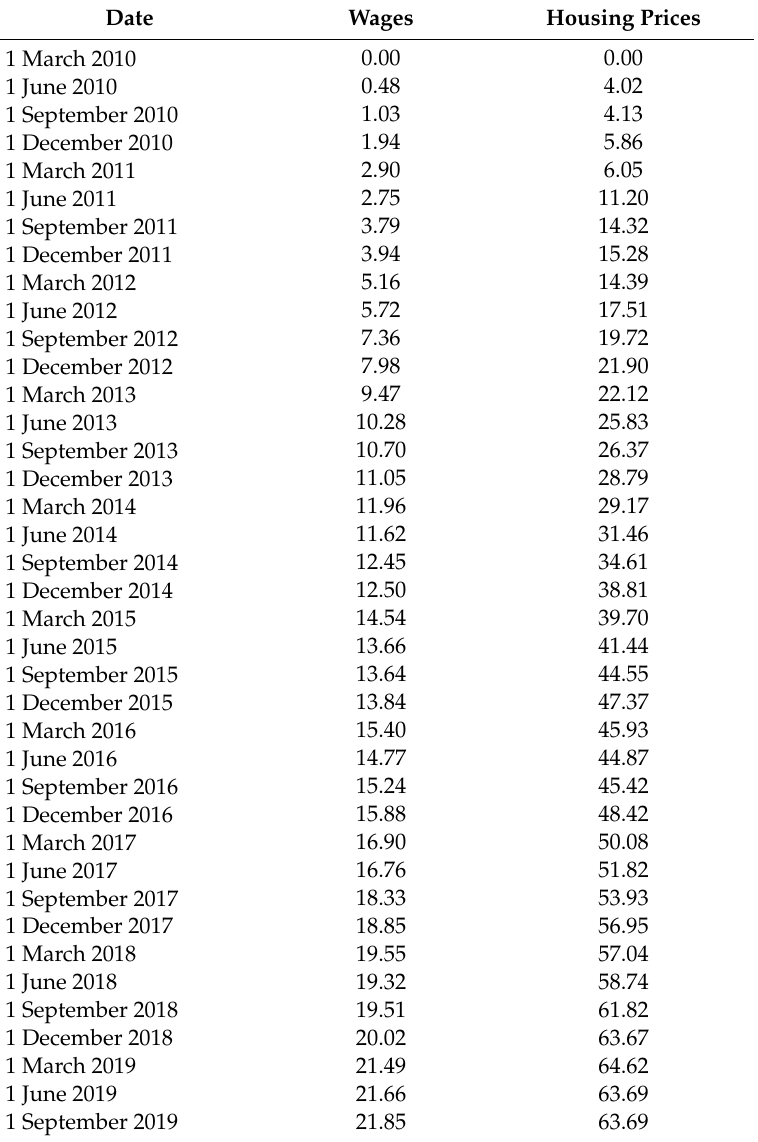
Table A1. Table of house prices versus